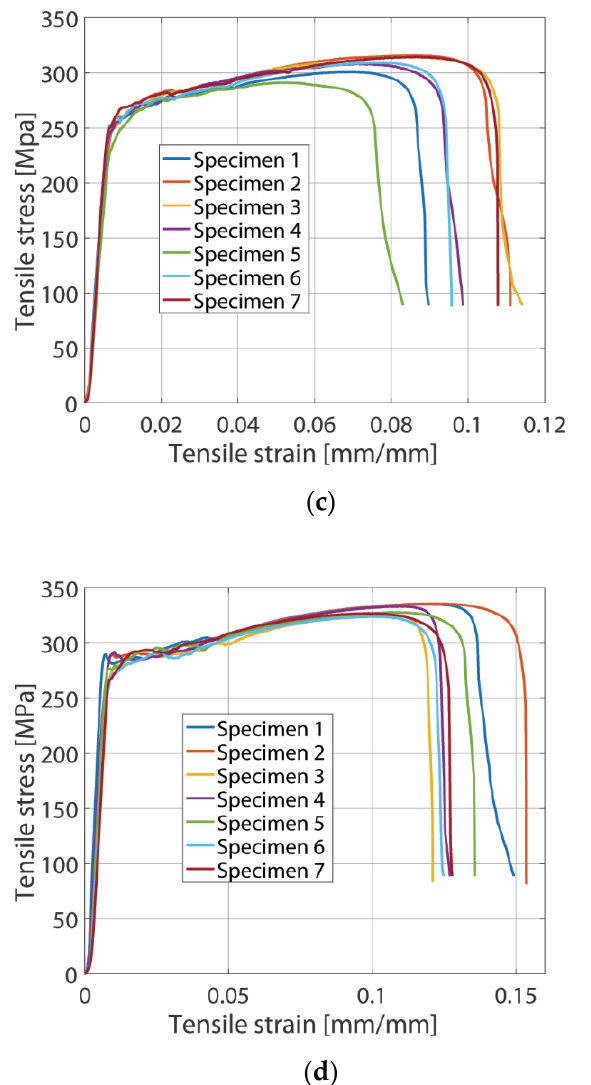
Figure 5. The engineering stress-strain curves for: unwelded specimens collected on rolling direction ( a ), unwelded specimens collected on transversal direction ( b ), one side welded specimens ( c ) and double side welded specimens ( d ).